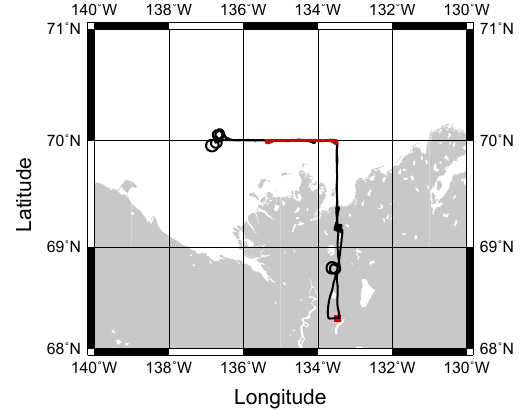
Figure 16. Track of VERDI Flight 7 from 29 April 2012. The red square marks the Mike Zubko Airport of Inuvik, NWT, Canada. The red line marks the flight track of the cloud profiling over the Beaufort Sea which is investigated further in this